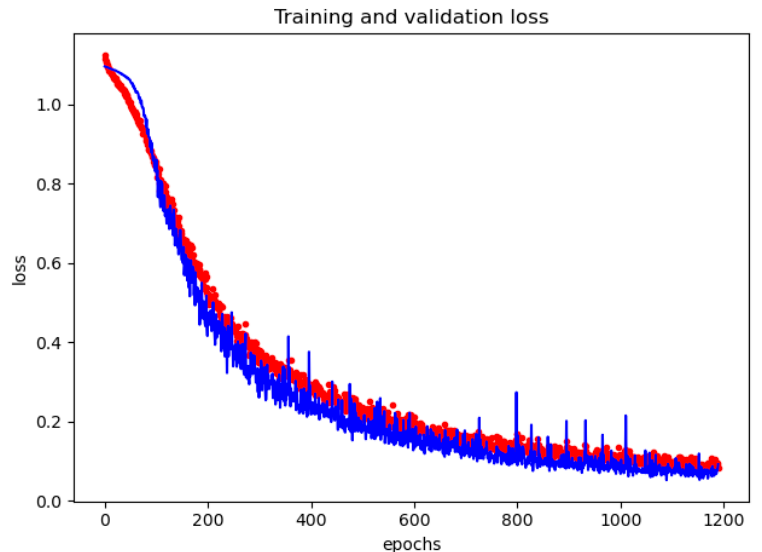
Figure 10. Evolution with the epochs of the loss during the training phase on the training set (red dotted curve) and validation set (blue solid curve) for the first fold.